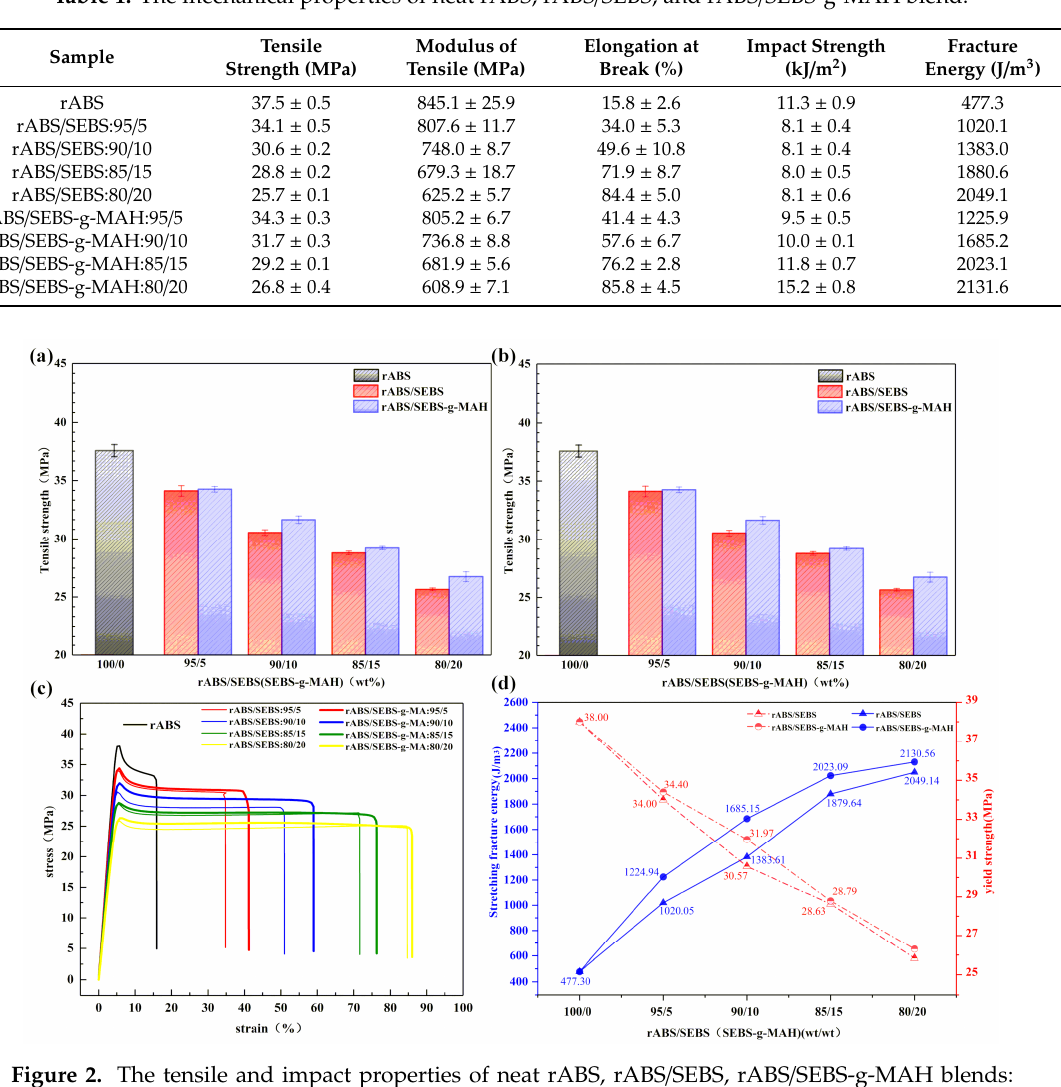
rABS/SEBS-g-MAH blend increases to 15.2 kJ/m 2 , which is higher than that of the recycled ABS and